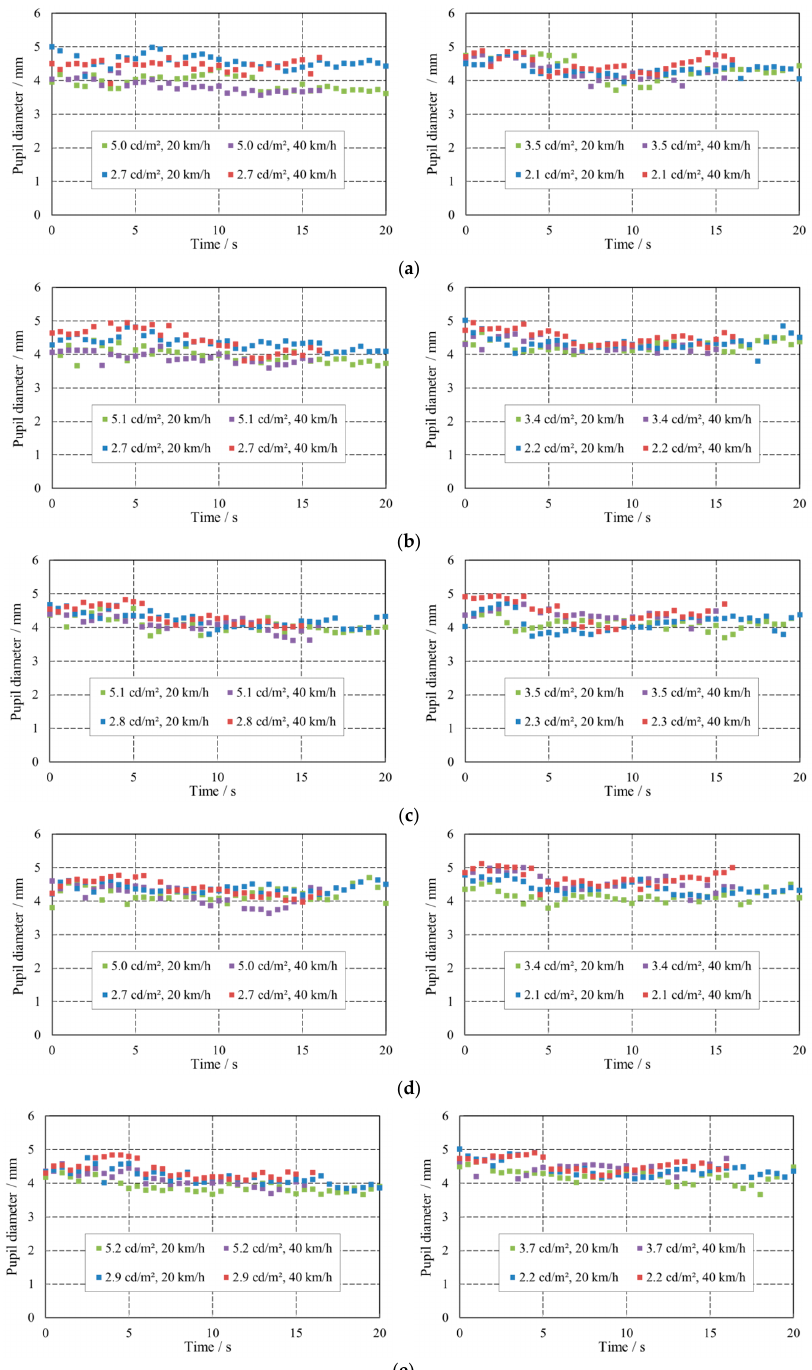
Figure 10. Driver’s pupil diameter change (left: sidewalls with energy ‐ storage and luminescent coating; right: sidewalls with gray cloth). ( a ) 2500 K, ( b ) 3500 K, ( c ) 4500 K, ( d ) 5500 K, ( e ) 6500 K.